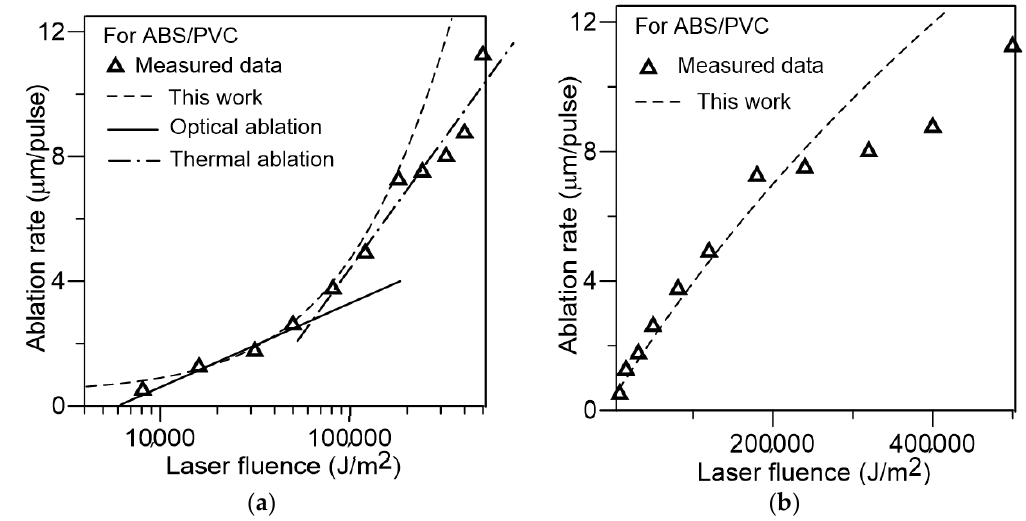
Figure 2. Ablation rate versus laser fluence of acrylonitrile butadiene styrene/polyvinyl chloride (ABS/PVC) for the dashed line predicted by this work and the triangle symbols measured by the published paper [13] ( a ) with the horizontal axis of the logarithm scale, and ( b ) with the horizontal axis of the linear scale.